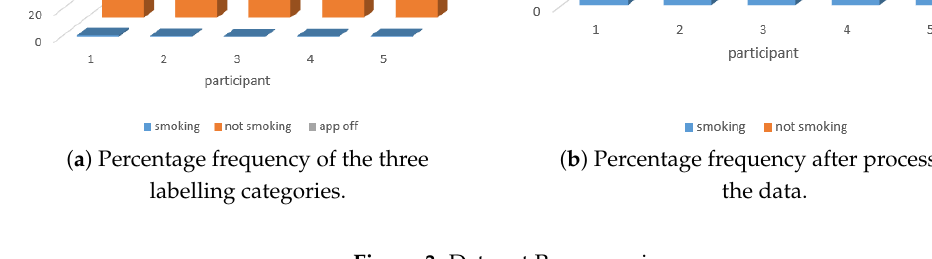
Figure 3. Data set Preprocessing.